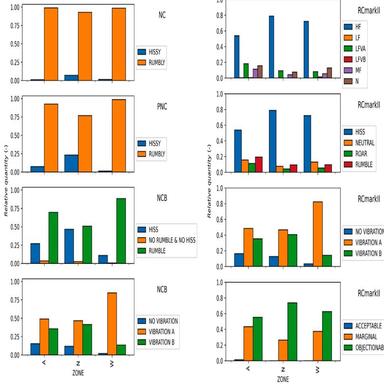
Quality parameters evaluation of the onboard noise using different indexes, classified by zones: accommodation (A), navigation (N), and work (W) spaces. Results are presented in percentages.